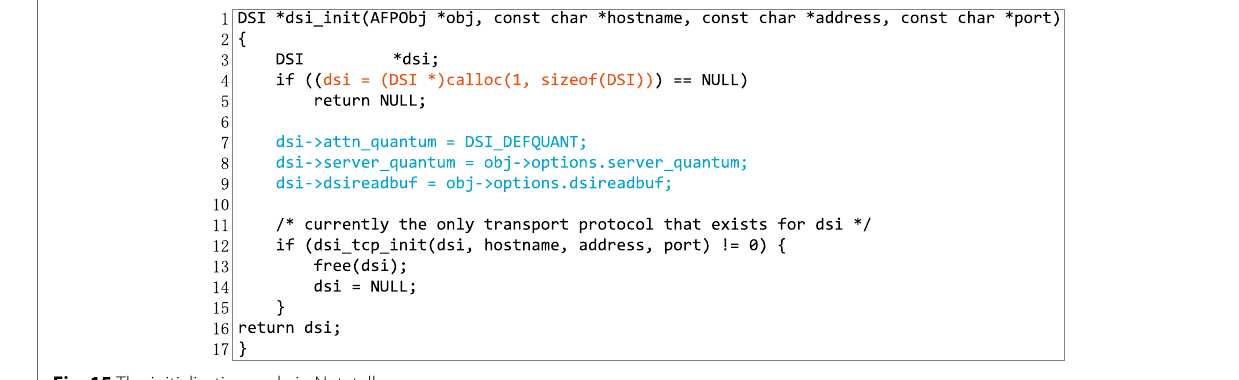
including global variables and function pointers in the .got segment.